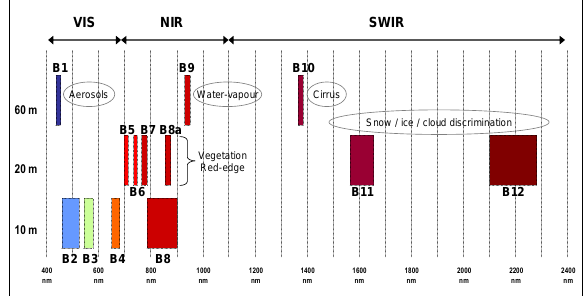
Figure 1: Spectral bands versus spatial resolution The Multi Spectral Instrument (namely MSI) is a push-broom imager based on a TMA (Tri Mirror Anastigmatic) telescope. It is opened at F/4 and the focal length is 0.60m. The focal plane is split in two parts: - a Visible and Near Infra Red (VNIR) focal plane made of 12 staggered CMOS detector modules - a Short Wave Infra Red (SWIR) focal plane made of 12 staggered Mercury Cadmium Telluride (MCT) detector modules hybridized on a CMOS read-out